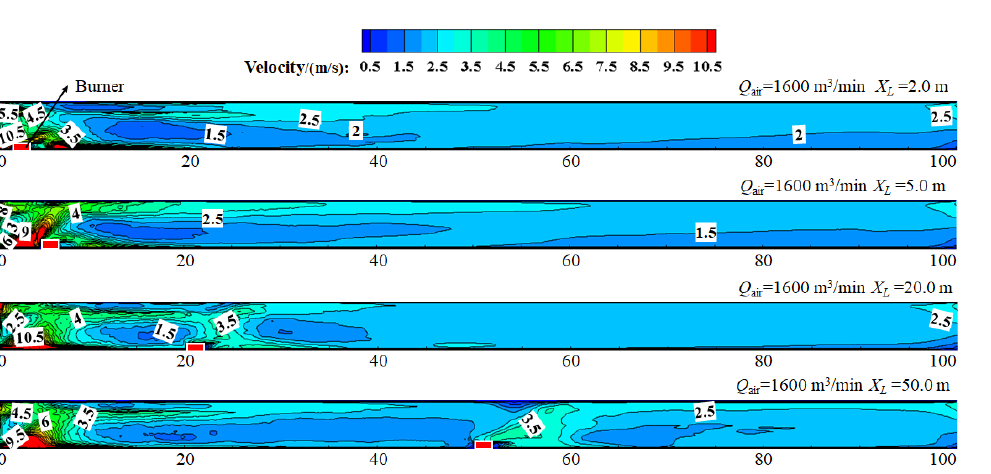
Figure 7. Longitudinal flow field distribution of the single-end tunnel under different fire